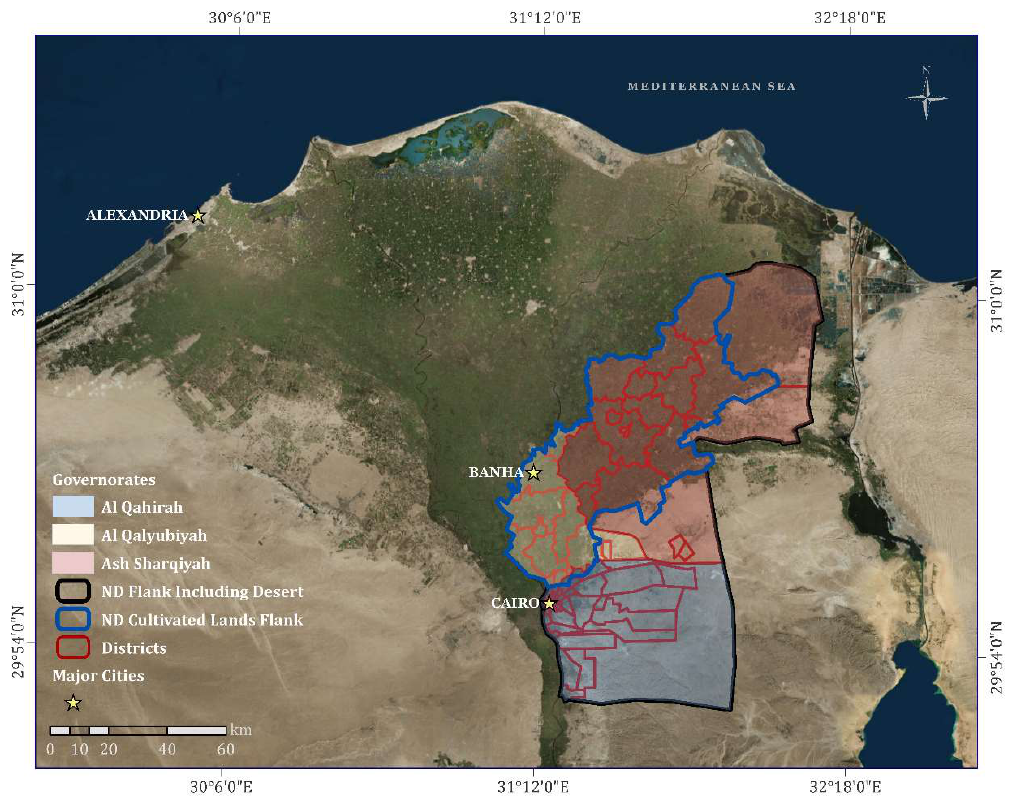
Figure 1. A map of the study area covering the eastern flank of the Nile Delta (ND) in Egypt. It shows the eastern ND flank including desert lands (indicated in black) and the cultivated lands flank of the ND (indicated in blue).